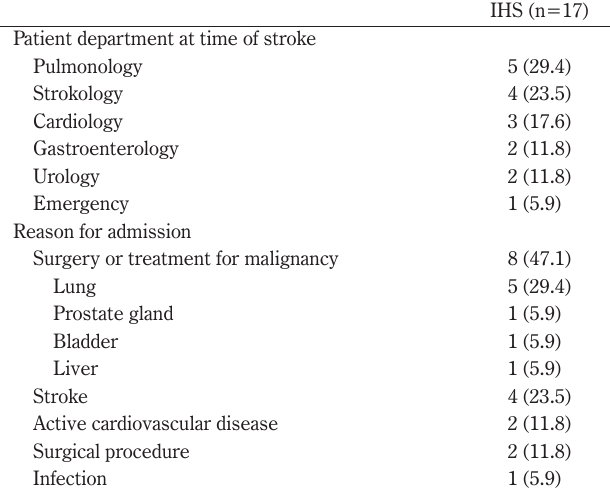
Table 2 Characteristics of patients with in-hospital stroke